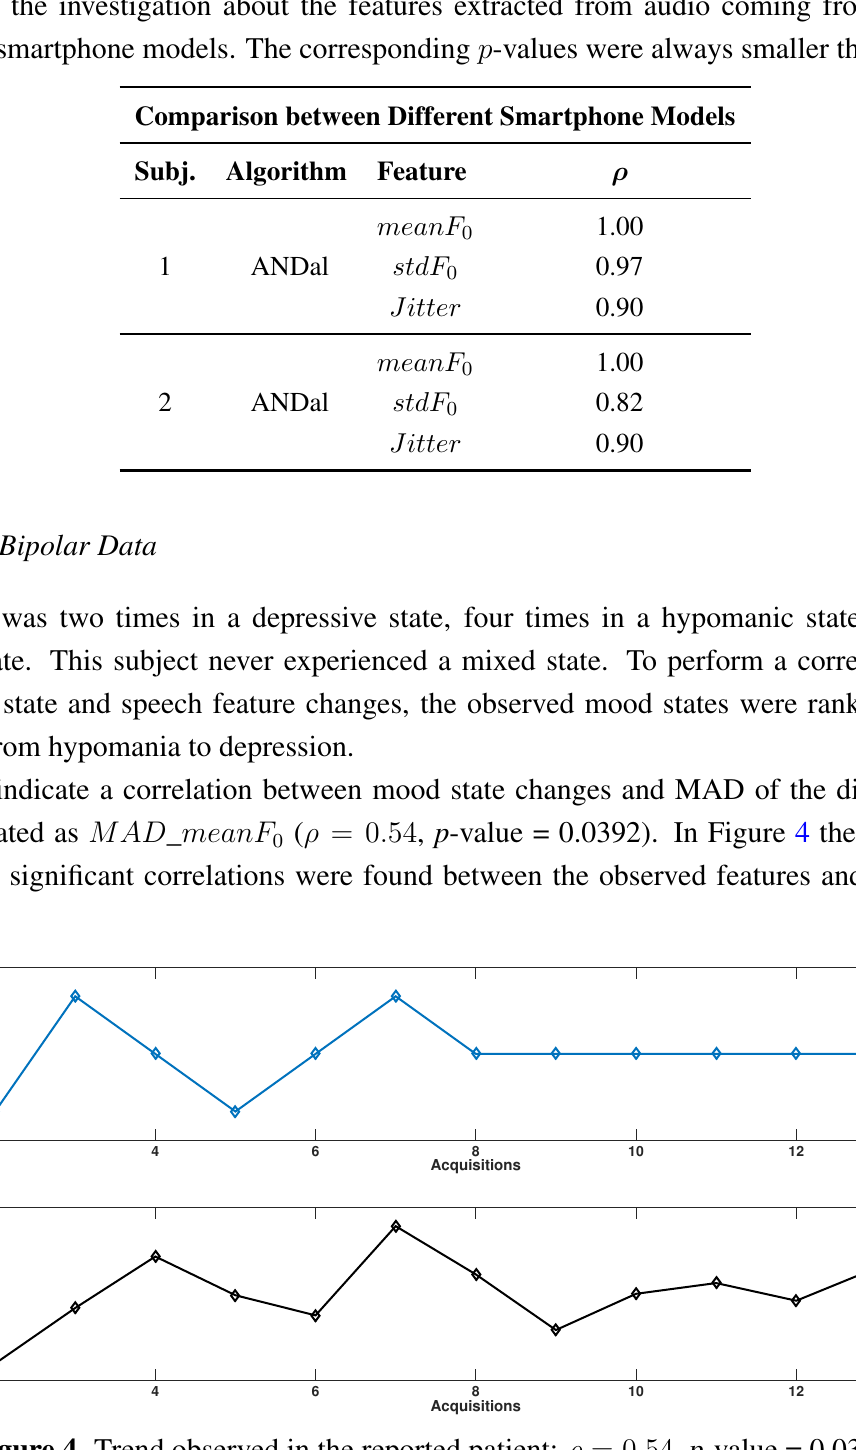
Figure 4. Trend observed in the reported patient: ρ = 0 . 54 , p -value =